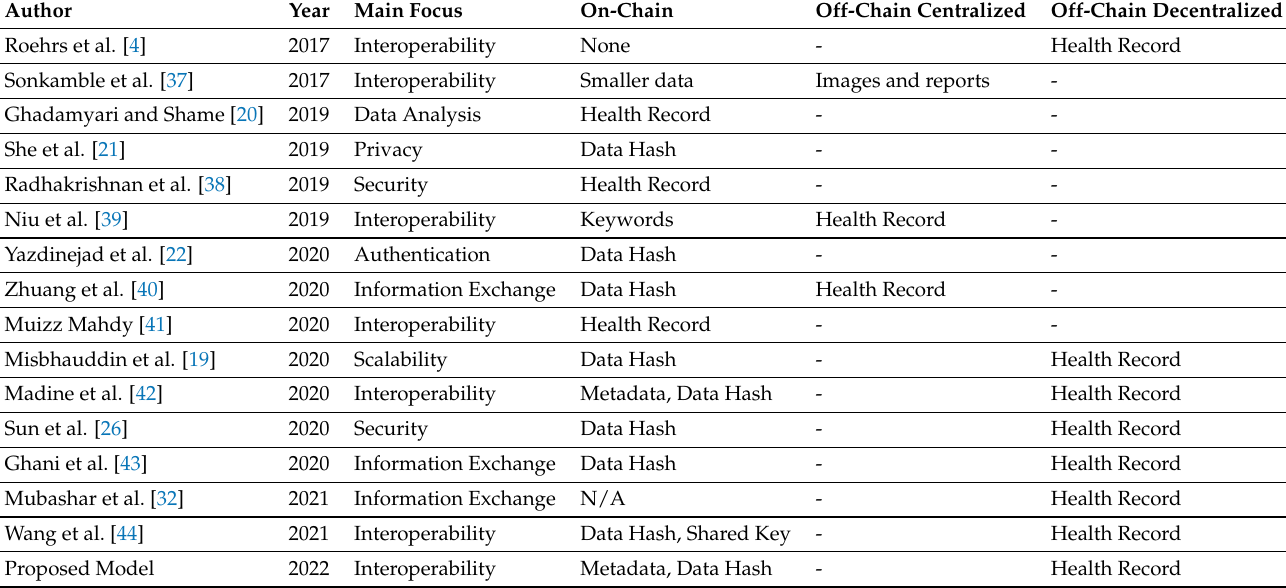
Table 3. Data location of previous models: Most models use a combination of on-chain and off-chain storage owing to blockchain scalability